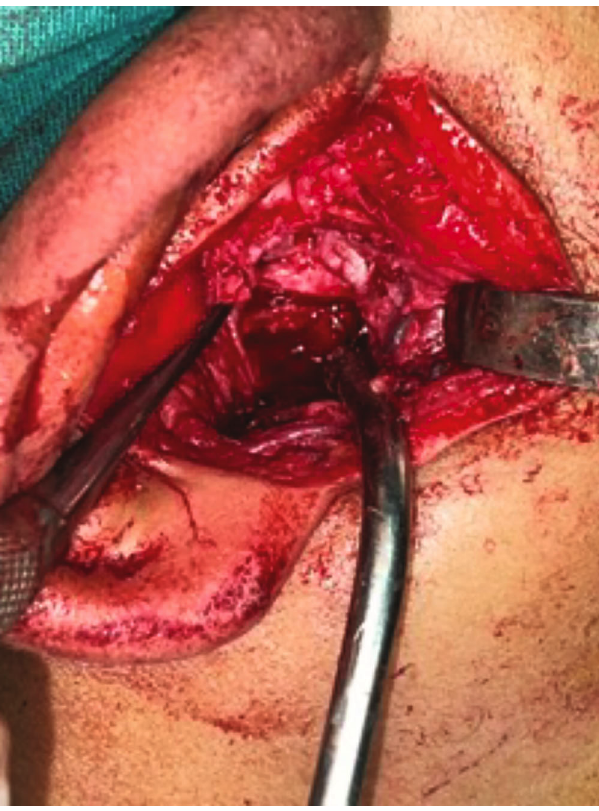
Figure 8: A gap is created following the removal of the ankylotic mass.